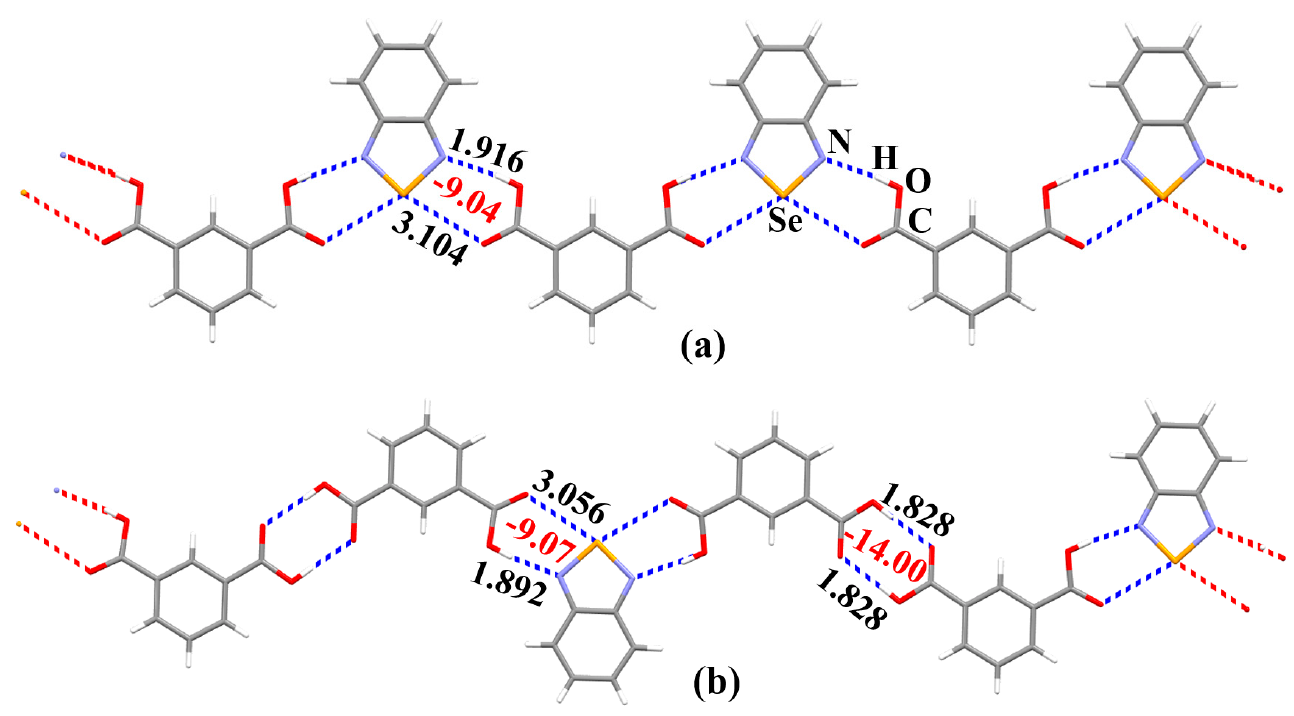
Figure 9. The interatomic distances (black numbers, Å) and interaction energies (red numbers, kcal/mol) for the three different synthons in cocrystals 1 ( a ) and 2 ( b ).